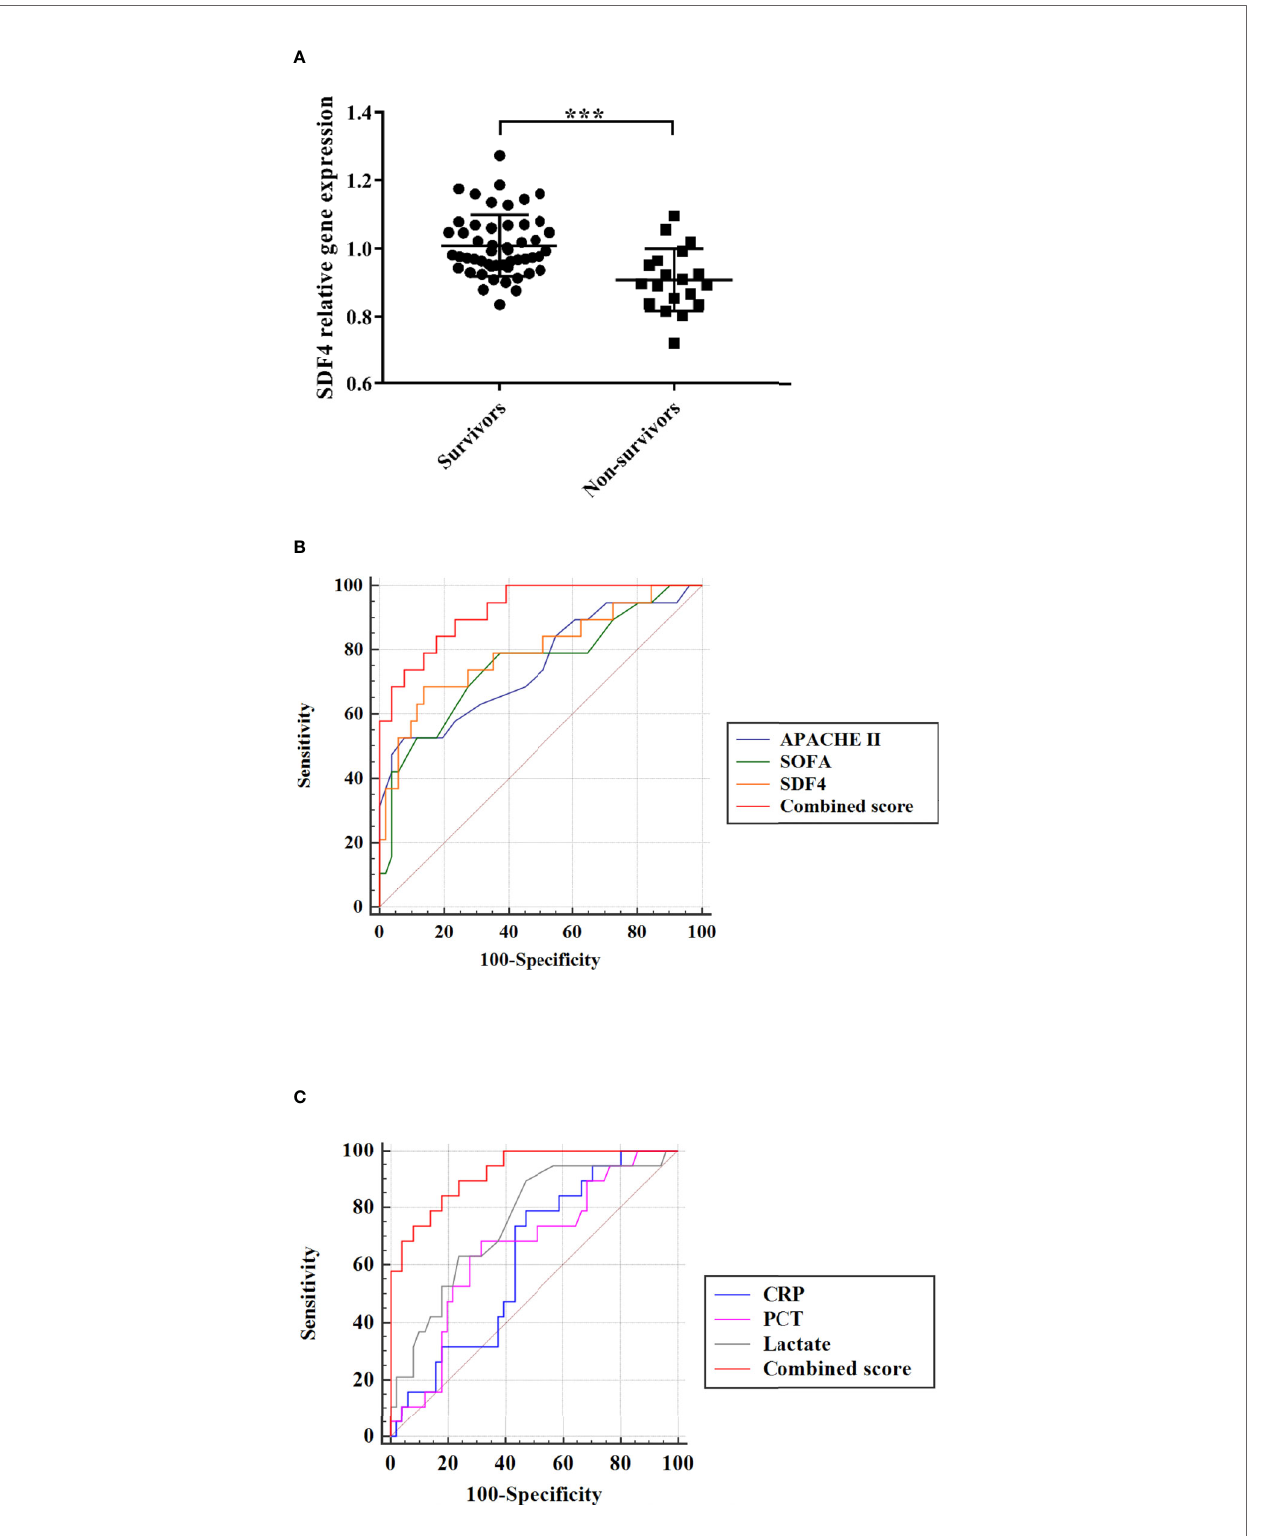
FIGURE 4 | (A) SDF4 expression in survival (n=51) compared with death (n=19) in validation cohort. (B) Receiver operating characteristics (ROC) curve of a diagnostic test based on SDF4 (AUC=0.794), APACHE II score (AUC=0.750), SOFA score (AUC=0.751) and combined score (AUC=0.925). (C) Receiver operating characteristics (ROC) curve of a diagnostic test based on CRP (AUC=0.624), PCT (AUC=0.659), lactate (AUC=0.752) and combined score. ***p <